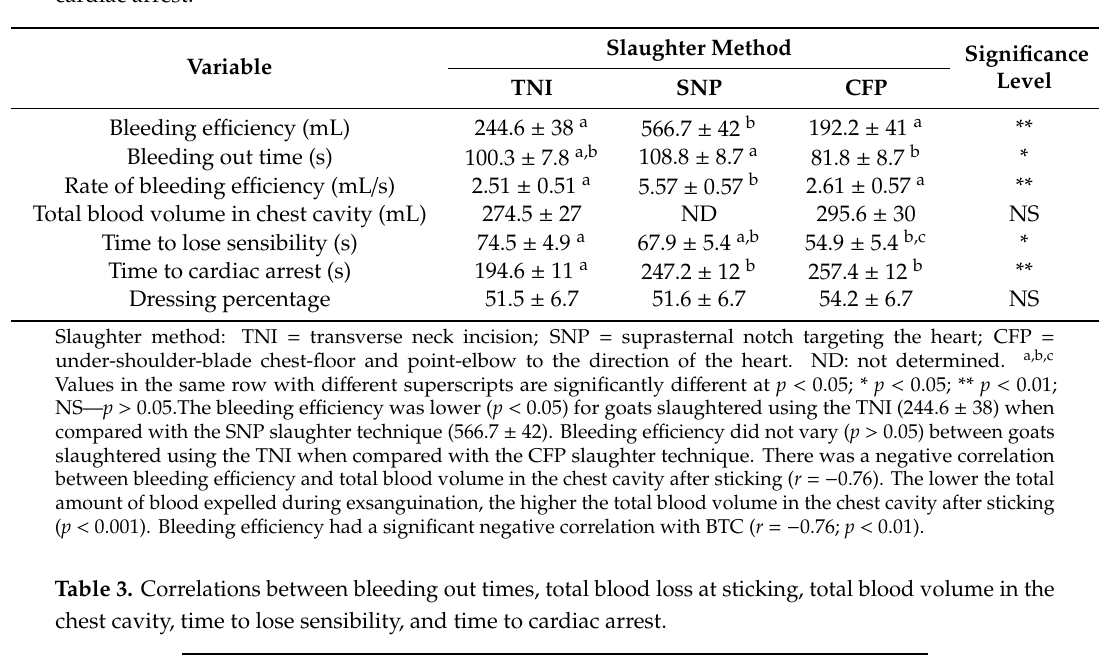
Table 2. The e ff ects of slaughter methods on bleeding e ffi ciency, time to lose sensibility, and time to cardiac arrest. Slaughter Method Significance Variable